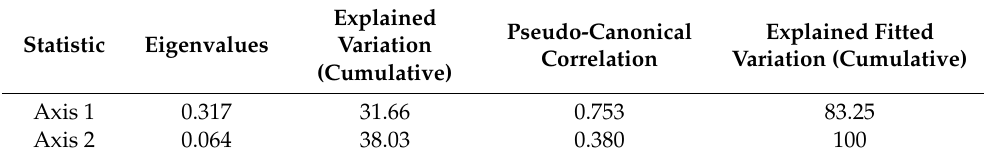
Table 3. Eigenvalues and correlation coefficients of communities and environmental factors on the first two axes of